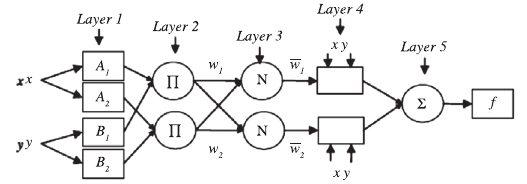
Figure 4. Schematic of ANFIS architecture 21